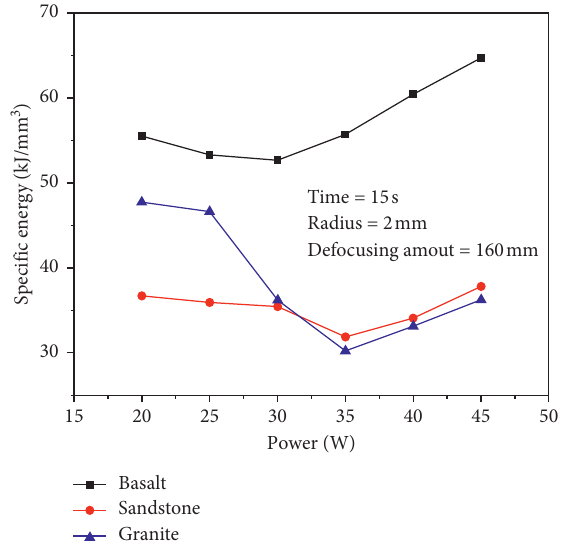
Figure 13: Effect of the laser power on specific energy (SE) of laser